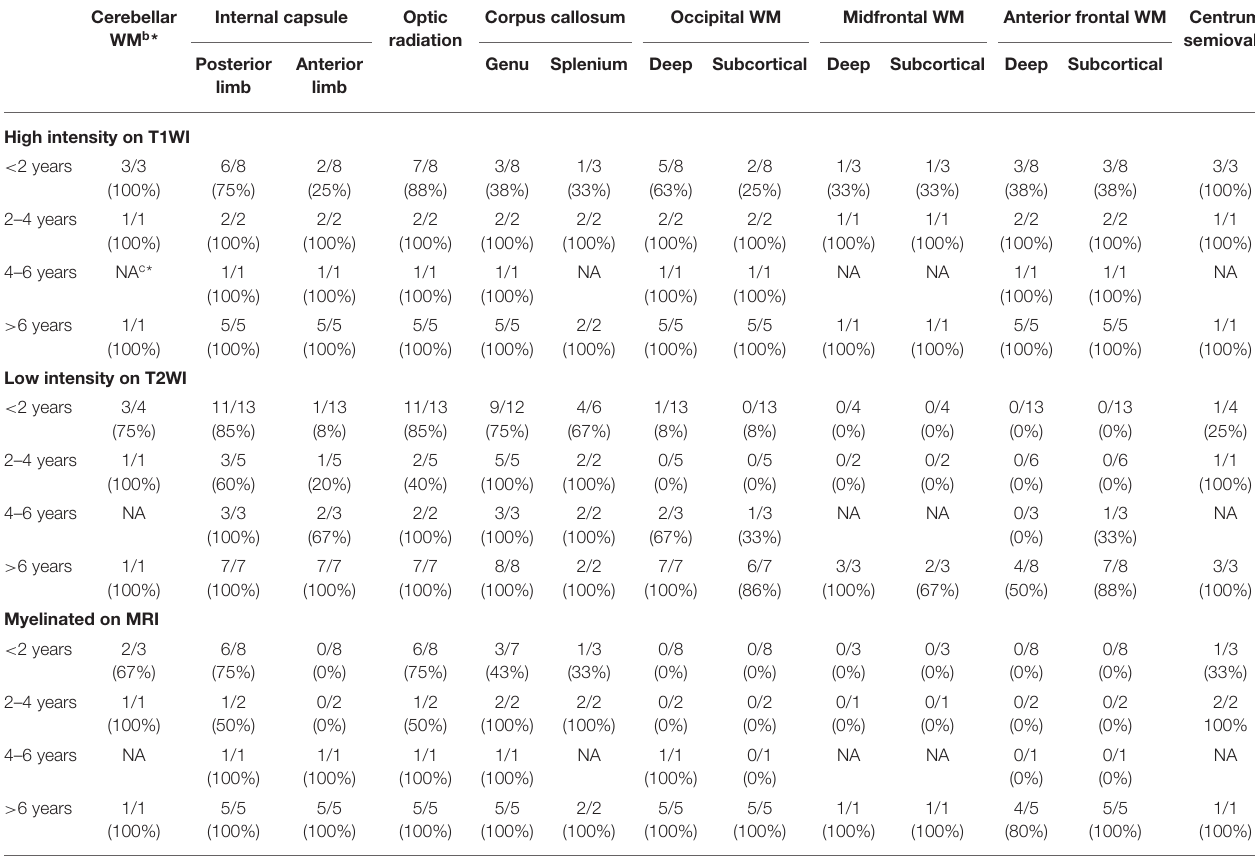
TABLE 3 | Myelination status in brain T1- and T2-weighted MRI images in published literature a *. Cerebellar WM b